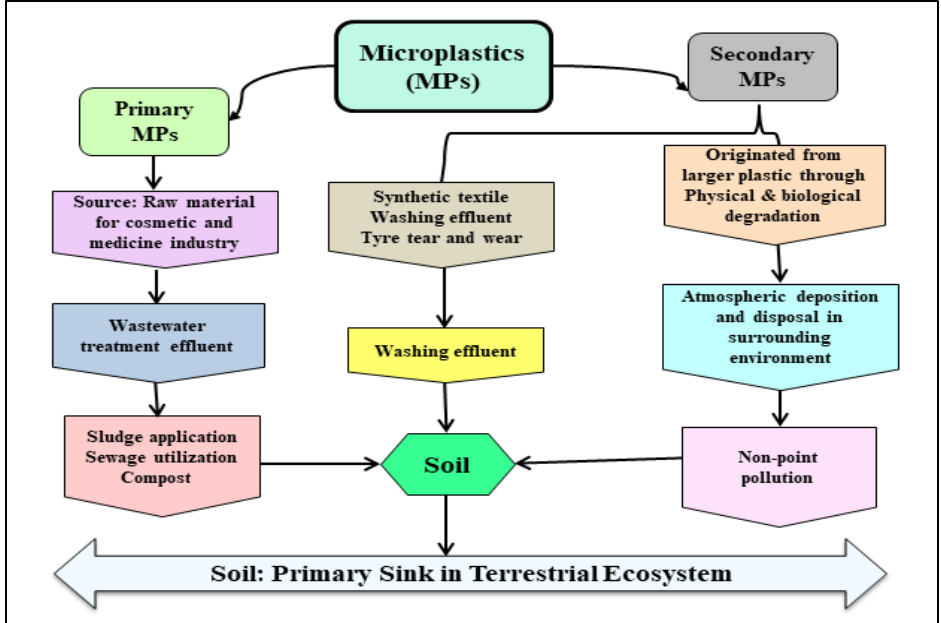
Figure 2. Schematic representation of the types of microplastics, sources, and sinks in the terrestrial